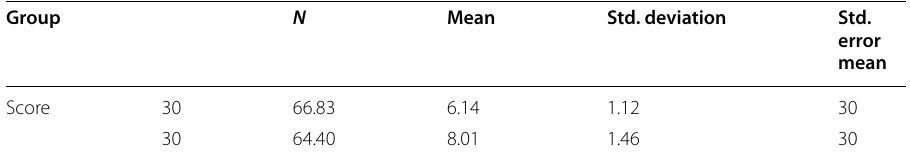
Table 26 Learner autonomy pre‑test descriptive statistics Group N Mean Std. deviation